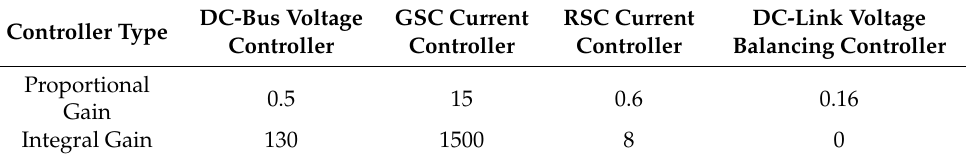
Table 4. Controller gains.